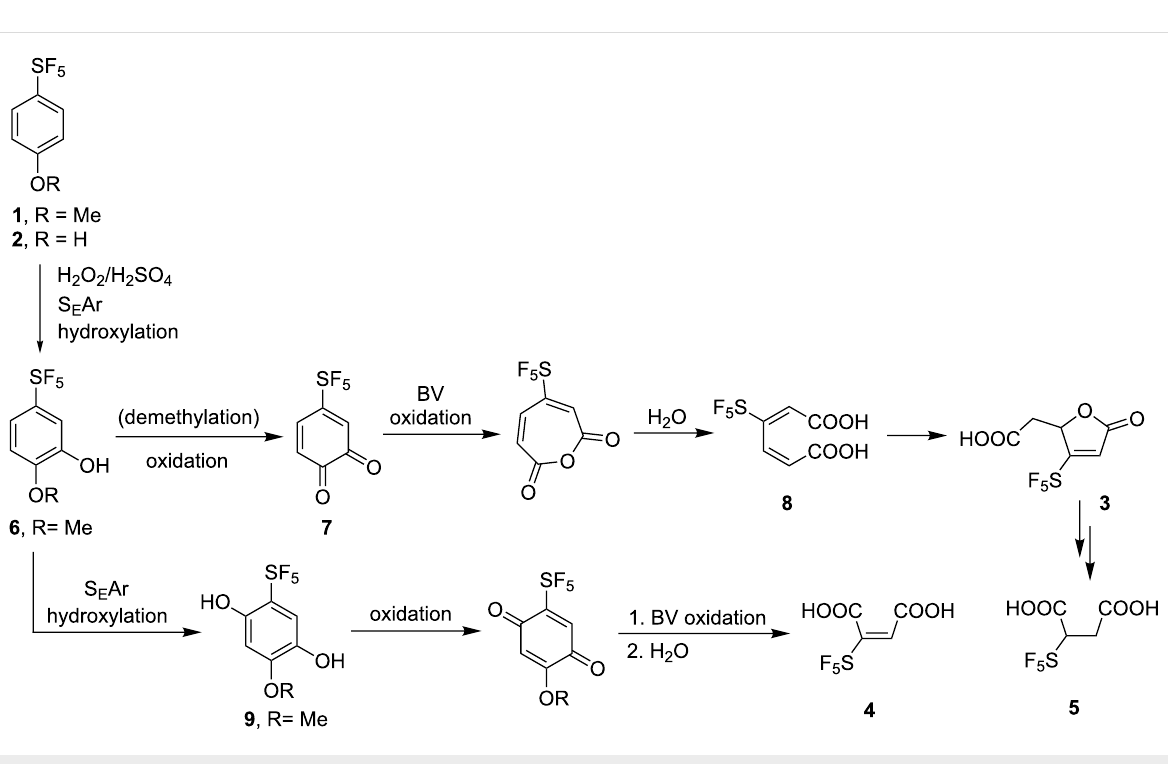
Scheme 2: Proposed mechanism for the formation of 3 and 4 from SF 5 aromatics 1 and 2